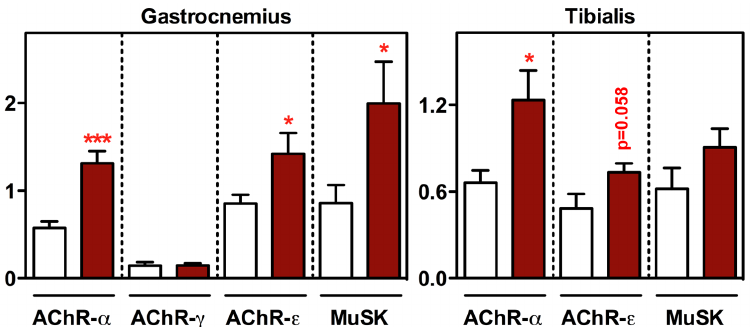
Figure 4. Gene expression specific to the motor end plate in SCD1 knockout mice. Expression of AChR- a , AChR- c , AChR- e and MuSK in gastrocnemius and tibialis anterior from SCD1 knockout mice (brown columns) and wild-type littermates (white columns). * P , 0.05, *** P , 0.001 (Unpaired t-test, n=4–11).